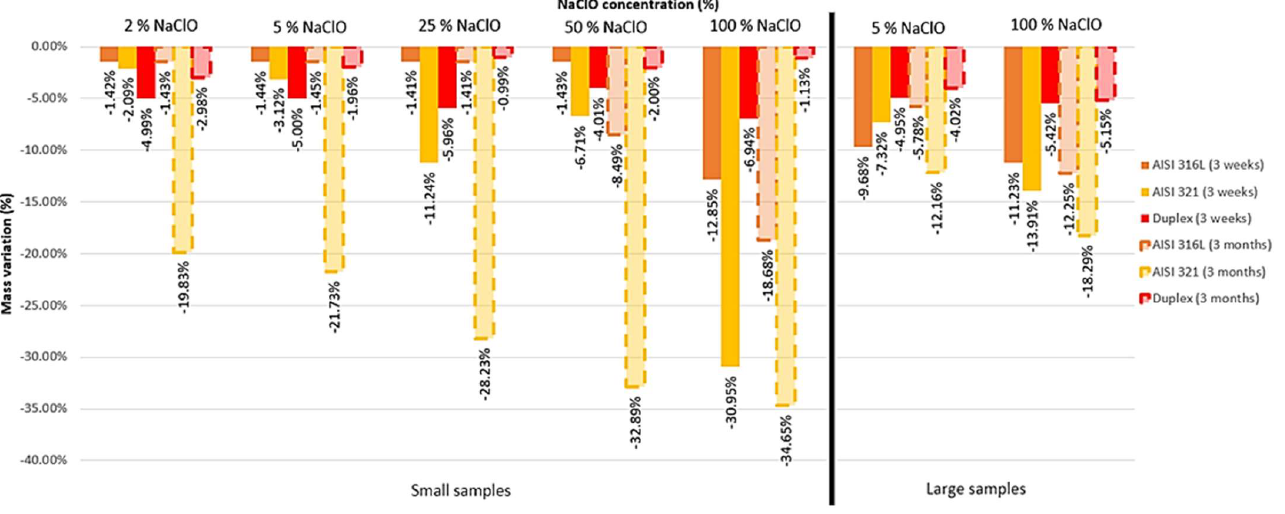
Figure 2. Mass variation of all the samples after three weeks and three months of immersion.